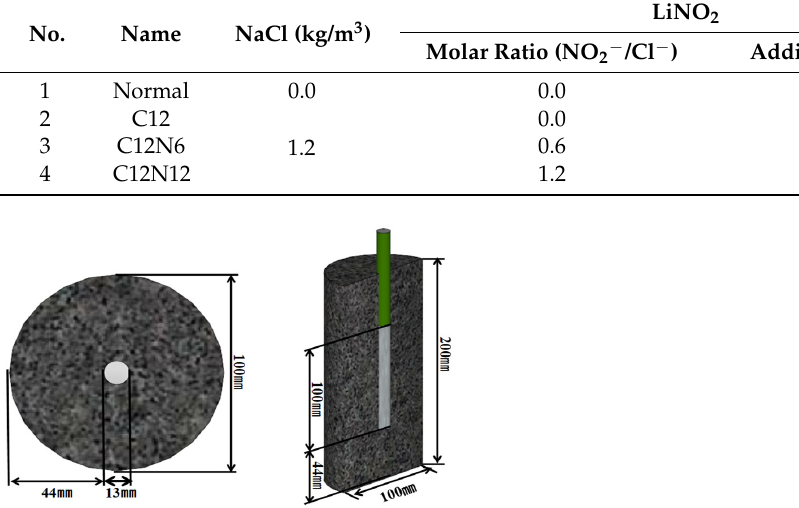
Figure 1. Schematic of specimen fabricated for electrochemical measurement.